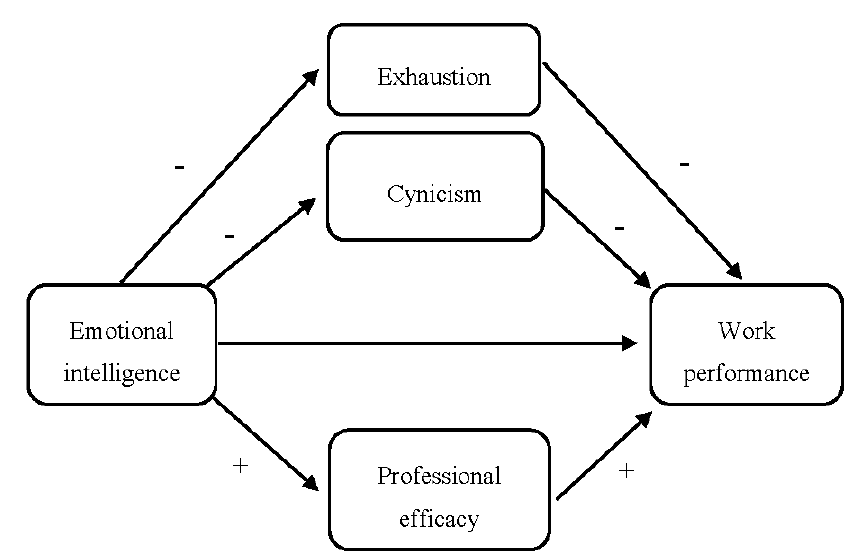
Figure 1. Proposed mediation model to empirically test the associations between emotional intelligence, the three burnout dimensions, and work performance.